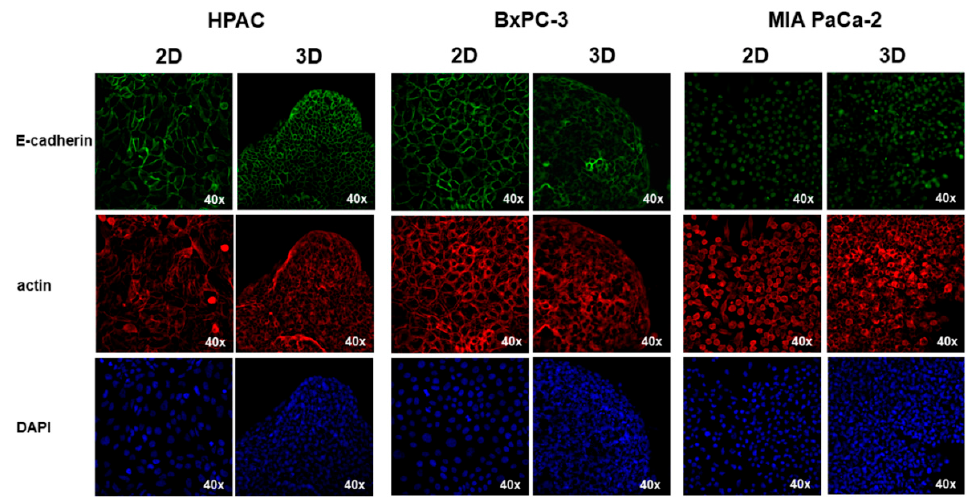
Figure 2. Immunofluorescence analysis for E-cadherin (green) and actin cytoskeleton (red) in PDAC cells cultured in 2D monolayers and 3D spheroids. The three PDAC cells exhibited an evident cortical actin, but E-cadherin immunoreactivity at cell membrane was detectable only in HPAC and BxPC-3 cells. Original magnification: 40×.